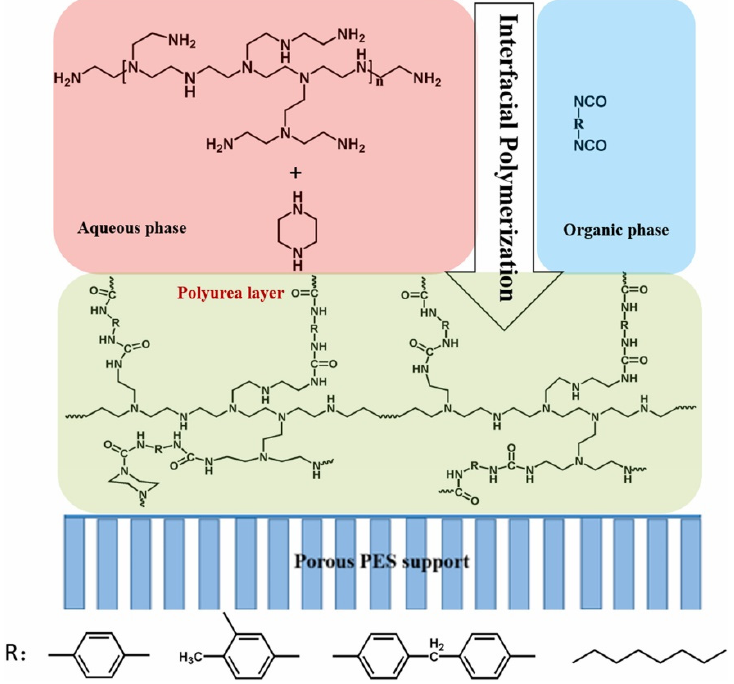
Figure 6. Reaction scheme for the TFC membrane preparation: representative polymer structure of functional layer [135].